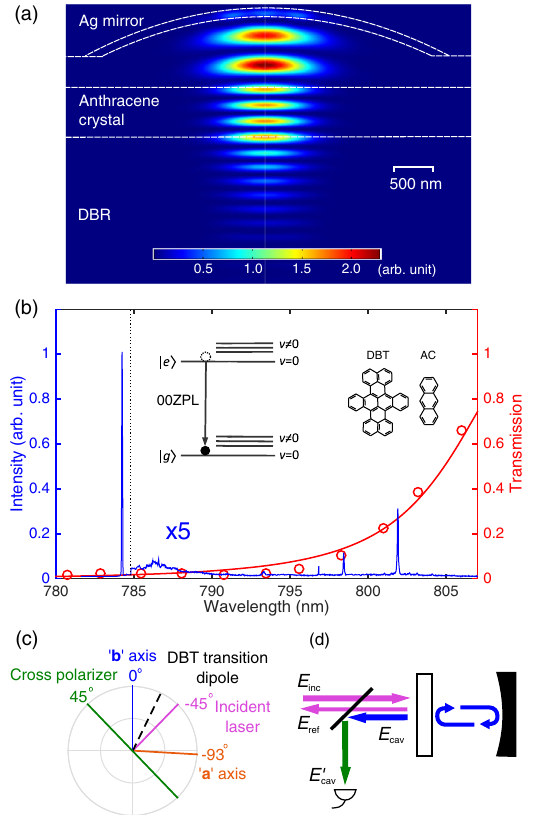
FIG. 2. (a) Microcavity design to scale, showing the electric field intensity distributions in a cavity mode. (b) The red curves show the measured (symbols) and calculated (solid line) trans- mission of the DBR at liquid helium temperature as a function of wavelength. The blue spectrum presents the emission of a molecule excited at 766 nm. The section beyond 785 nm is magnified by 5 times for clarity. (c) Relative position of AC crystal axes, laser, and detection polarizations as well as the orientation of the DBT dipole moment in the DBR plane. (d) The arrangement for cross-polarized